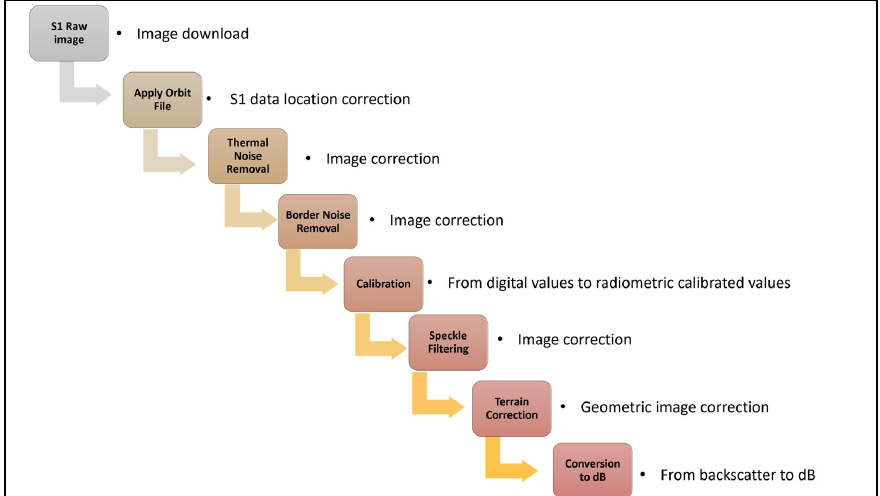
Figure 2. Workflow followed for the pre-processing of S1 images to obtain backscatter